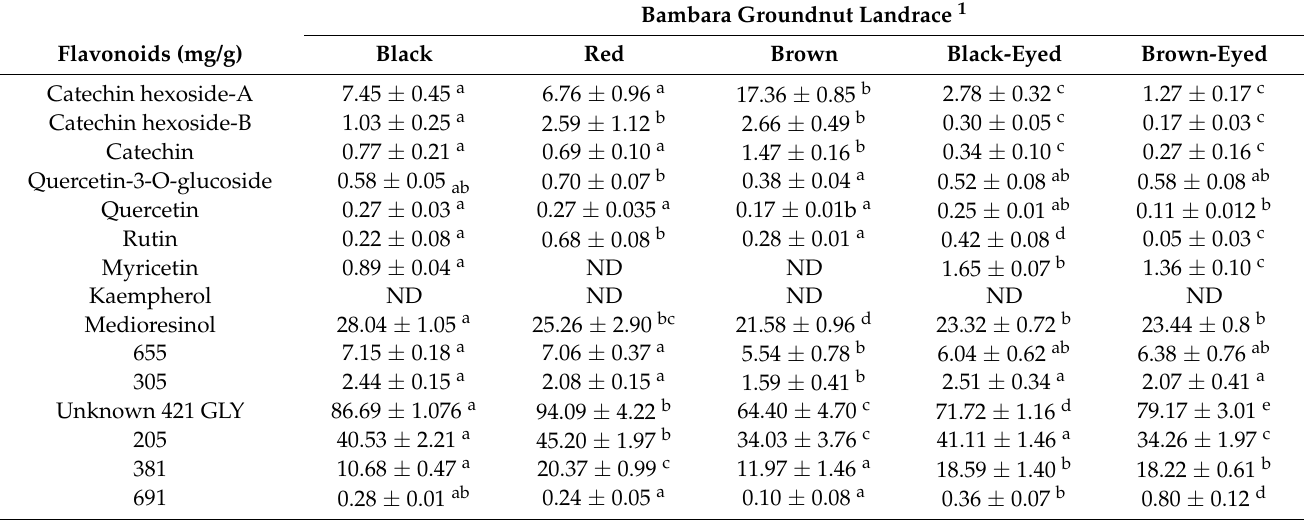
Table 2. Flavonoids detected in the ethanolic extracts of the cotyledons of five different Bambara groundnut